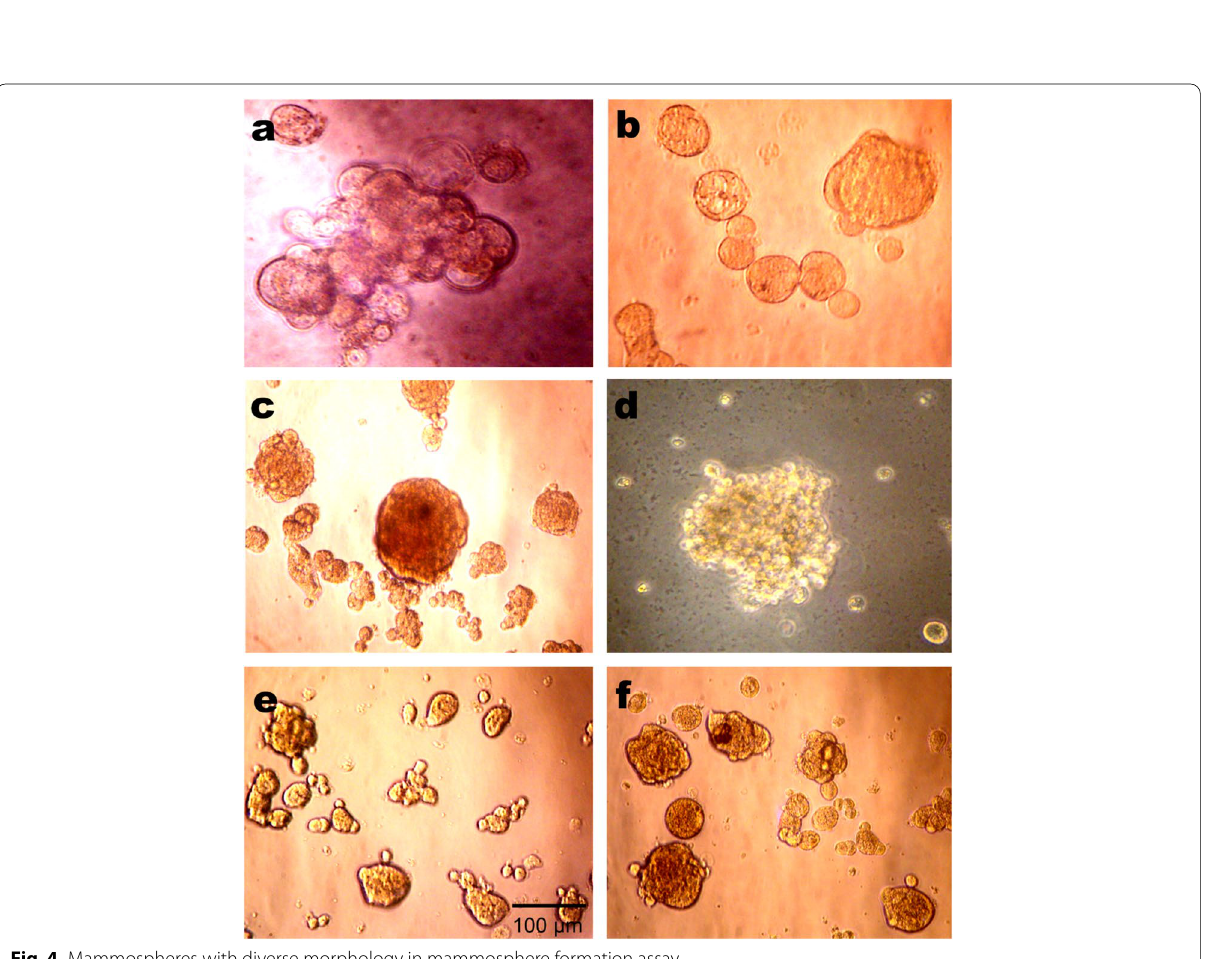
Fig. 4 Mammospheres with diverse morphology in mammosphere formation